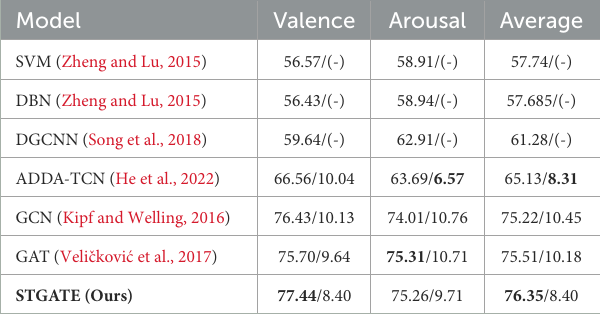
TABLE 2 Leave-one-subject-out emotion recognition (accuracy/standard deviation) on the DREAMER